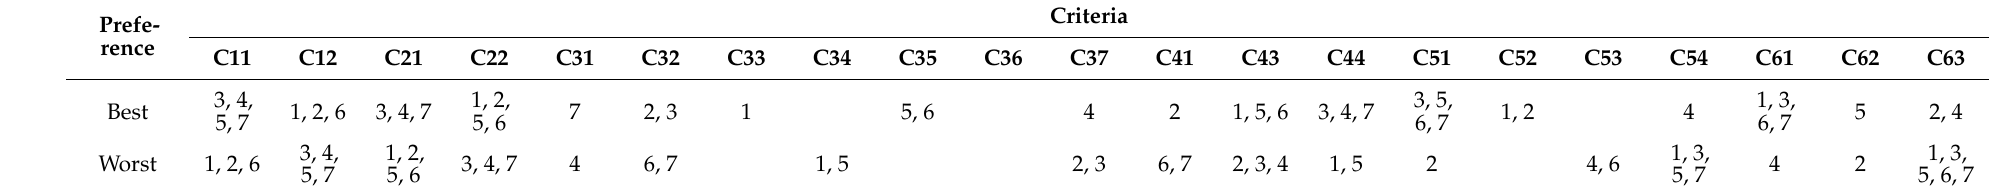
Table 8. Best and worst criteria identified by experts.